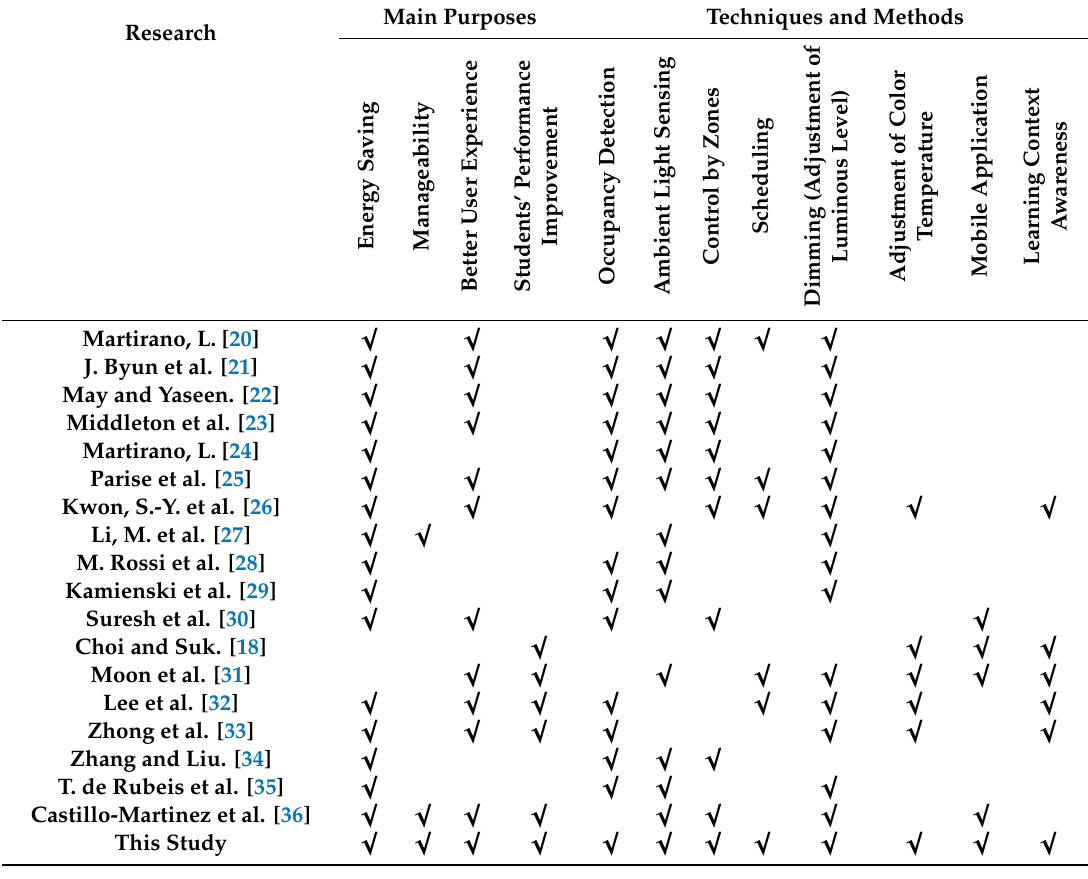
Table 1. Comparison of studies on lighting control